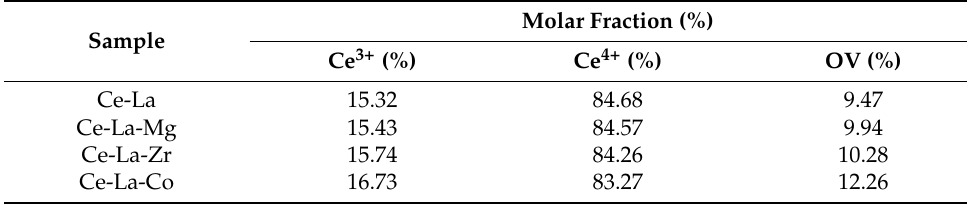
Table 4. Surface concentrations of Ce and O estimated by